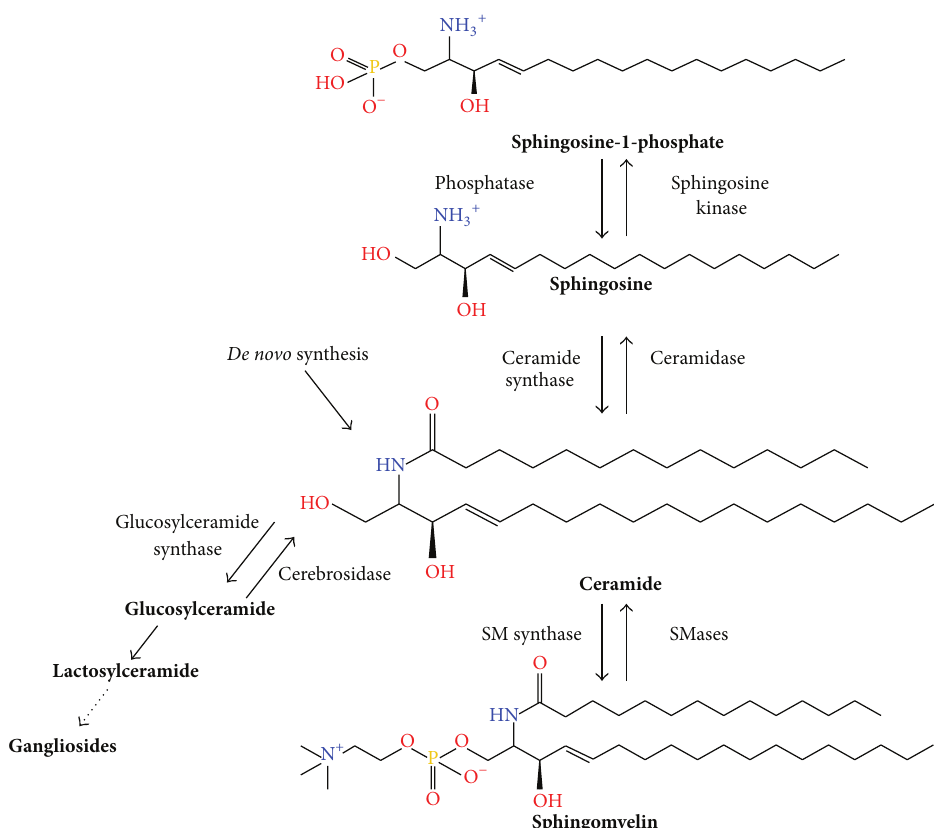
Figure 2: Overview of sphingolipid synthesis. Sphingolipids contain a sphingosine backbone that is modified to produce an array of metabolites. Ceramide serves a central role and can be synthesized by breakdown of sphingomyelin, addition of fatty acid by ceramide synthase, or de novo synthesis from serine palmitoyltransferase. Ceramide and sphingosine can be phosphorylated by their respective kinases to form bioactive metabolites. More complex sphingolipids are formed from ceramide, including sphingomyelin and